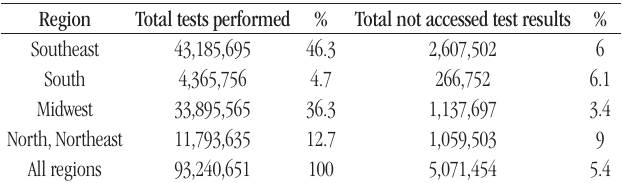
taBLE 2 – Absolute numbers and respective rates of “not accessed” laboratory test results performed by 81 laboratories from May 1, 2016 to May 1, 2017, by Brazilian geographic region Region